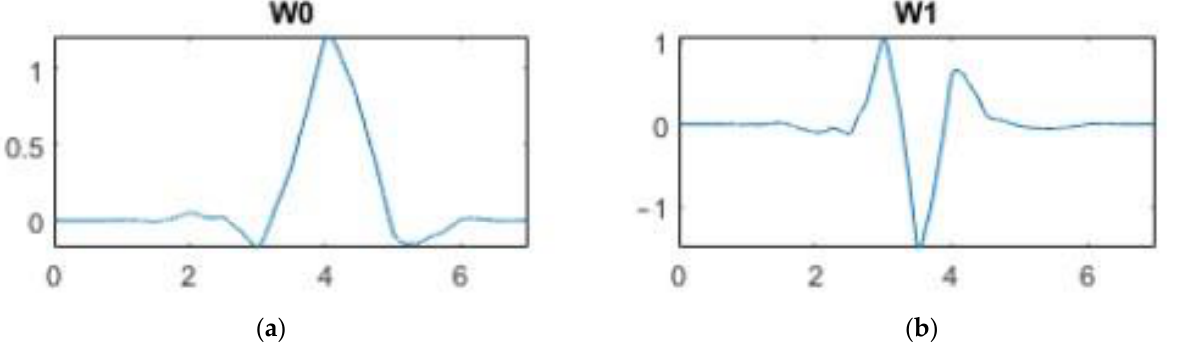
Figure 4. ( a ) Scaling function; ( b ) wavelet function.